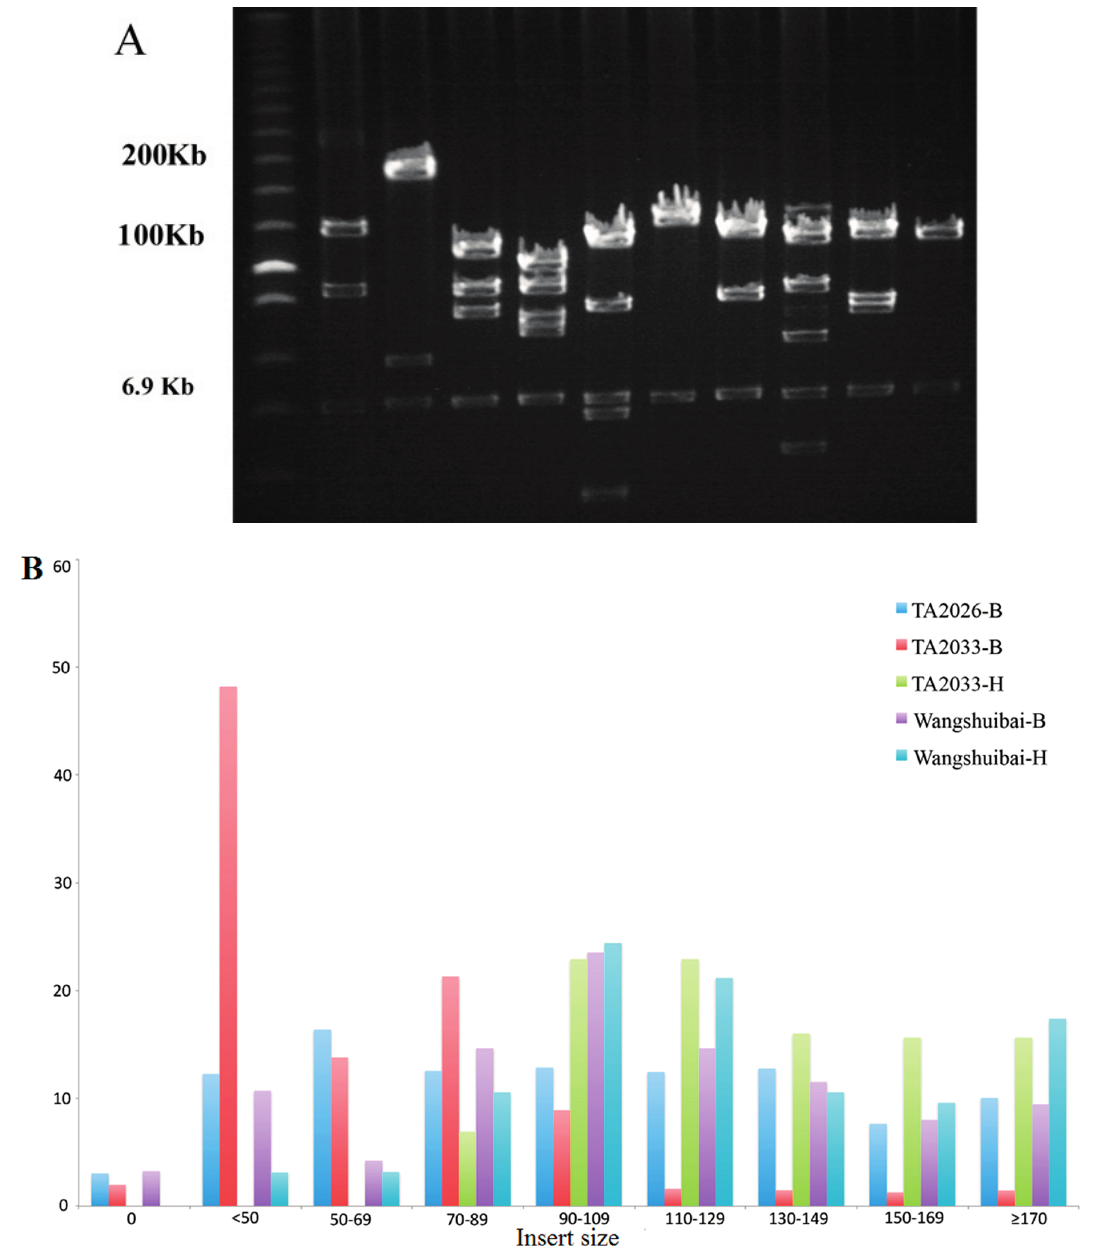
Figure 1. Insert size distribution of bacterial artificial chromosome (BAC)